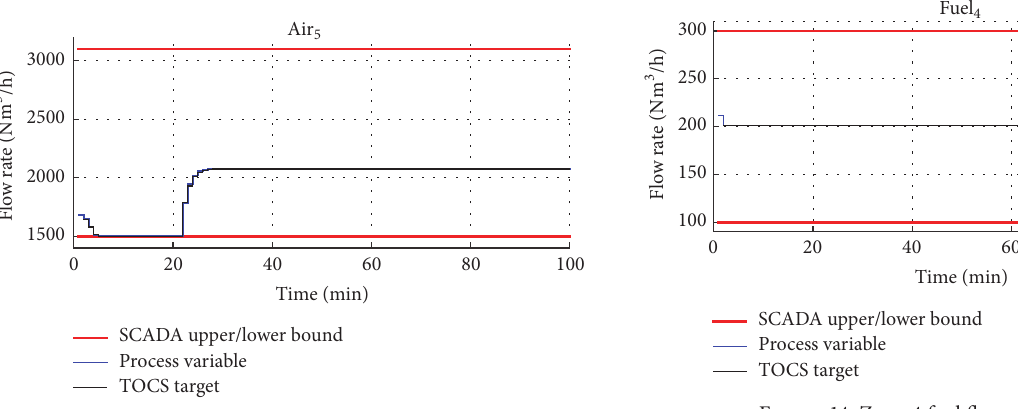
Figure 11: Zone 5 air flow rate trends.